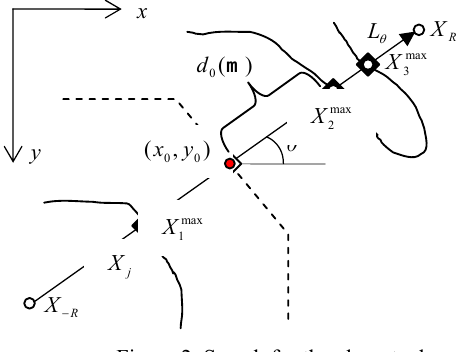
Figure 2. Search for the closest